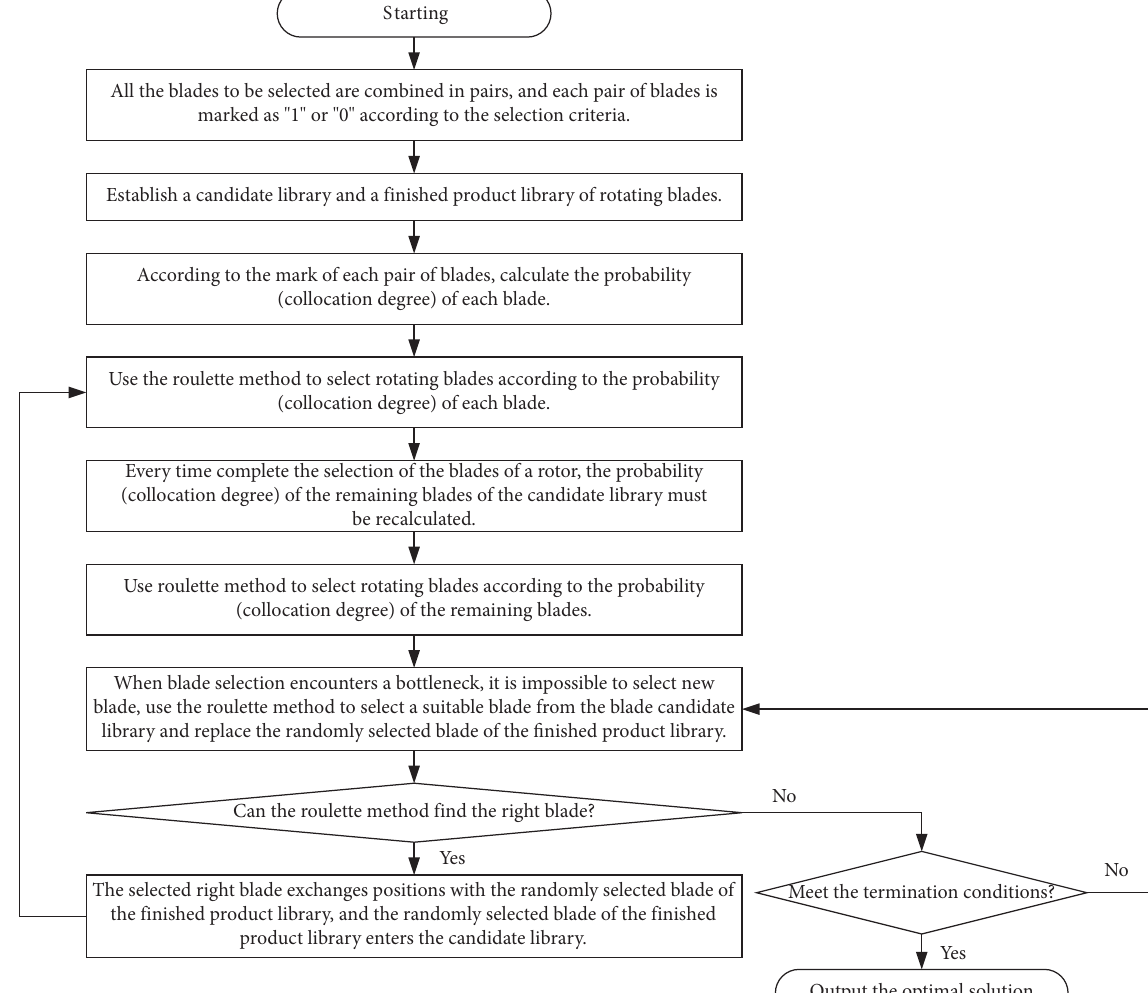
Figure 4: The flowchart of the optimization algorithm of selecting rotating blades based on the collocation degree of